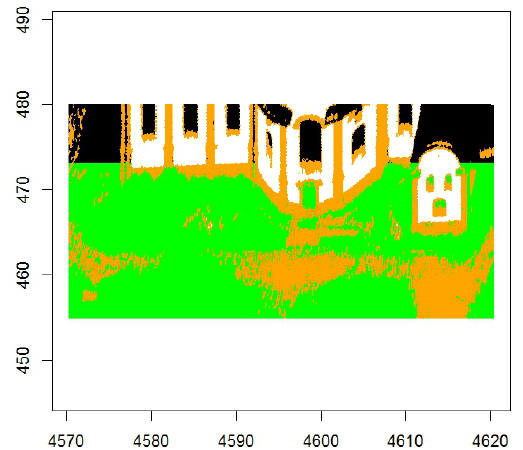
The annotated façade plot is generated using the decision tree derived before. For each cell of the point cloud a class is assigned. The result is plotted using a symbol and a colour for each class (cf. Figure 6).